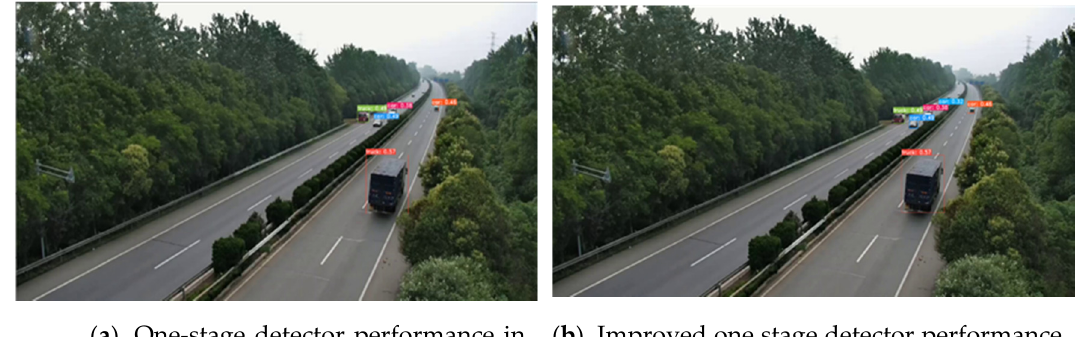
Figure 5. Comparison of improved one-stage detector and one-stage detector in highway environment.